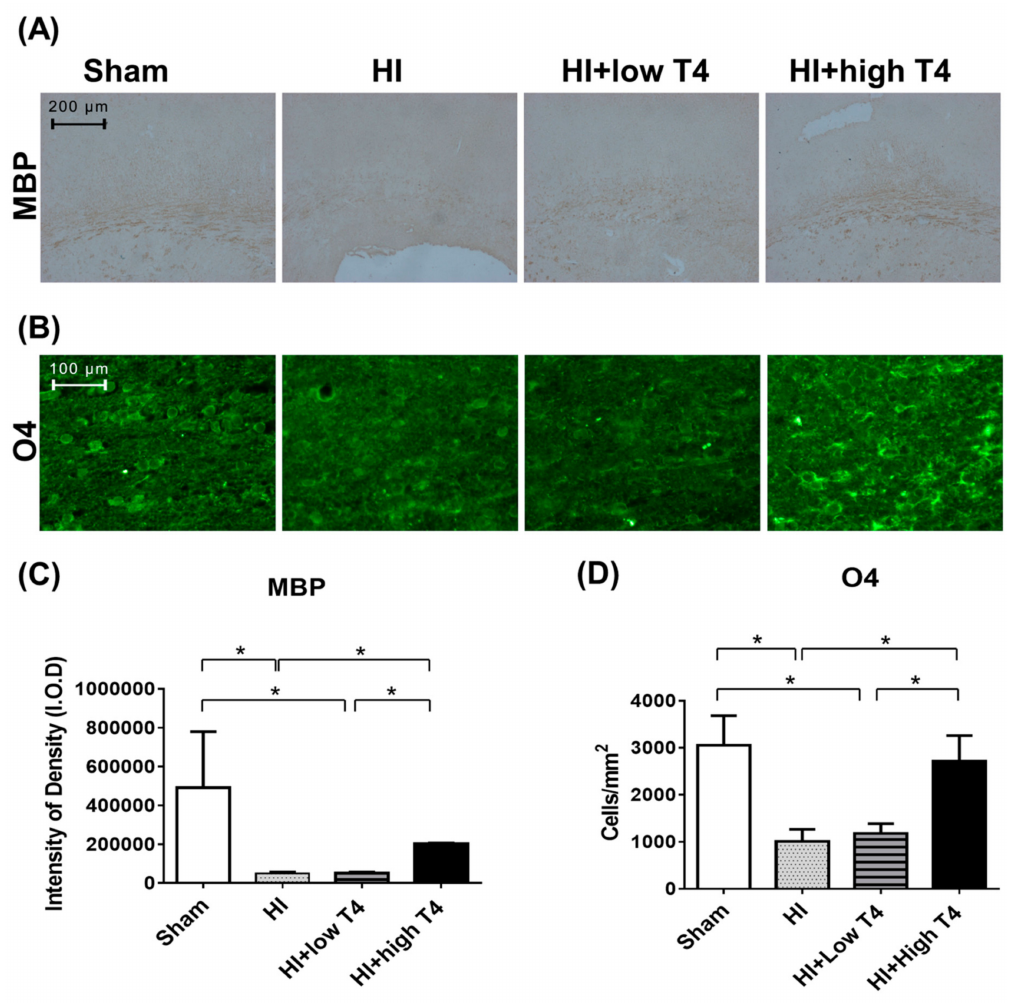
Figure 1. Thyroxin treatment reversed hypoxic-ischemic (HI)-induced white-matter (WM) injury. ( A ) The (HI) and HI+low thyroxin (T4) groups showed weak myelin basic-protein (MBP) immunostaining compared to the sham group, whereas the HI+high T4 group displayed strong MBP immunoreactivity. Scale bar, 200 µ m. ( B ) Few positive cells for O4 immunofluorescence were observed in the HI and HI+low T4 groups. A great number of O4-immunostained cells remained in the HI+high T4 groups. Scale bar, 100 µ m. ( C ) Intensity of density (I.O.D) of MBP staining in the WM. The I.O.D of MBP staining in the HI and HI+low T4 groups were significantly lower compared to the sham group, while HI+high T4 treatment attenuated the HI-induced loss. ( D ) HI reduced the number of O4-positive cells, whereas HI+high T4 treatment significantly increased the number of O4-immunostained cells compared to both HI and HI+ low T4 groups. * p <